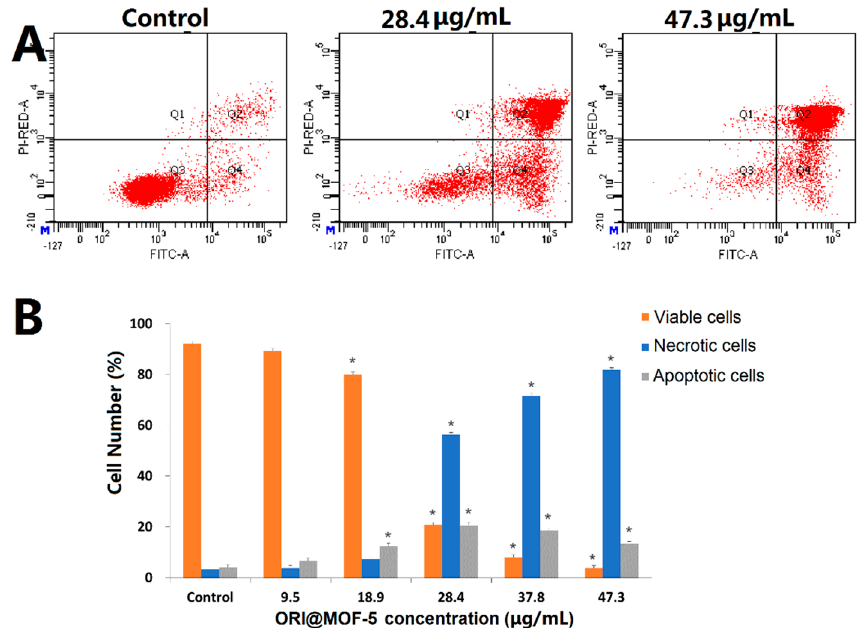
Figure 11. ( A ) Apoptosis assays for HepG2 cells after treatment with di ff erent concentrations of ORI@MOF-5 for 24 h; ( B ) Statistical analysis of viable, necrotic, and apoptotic HepG2